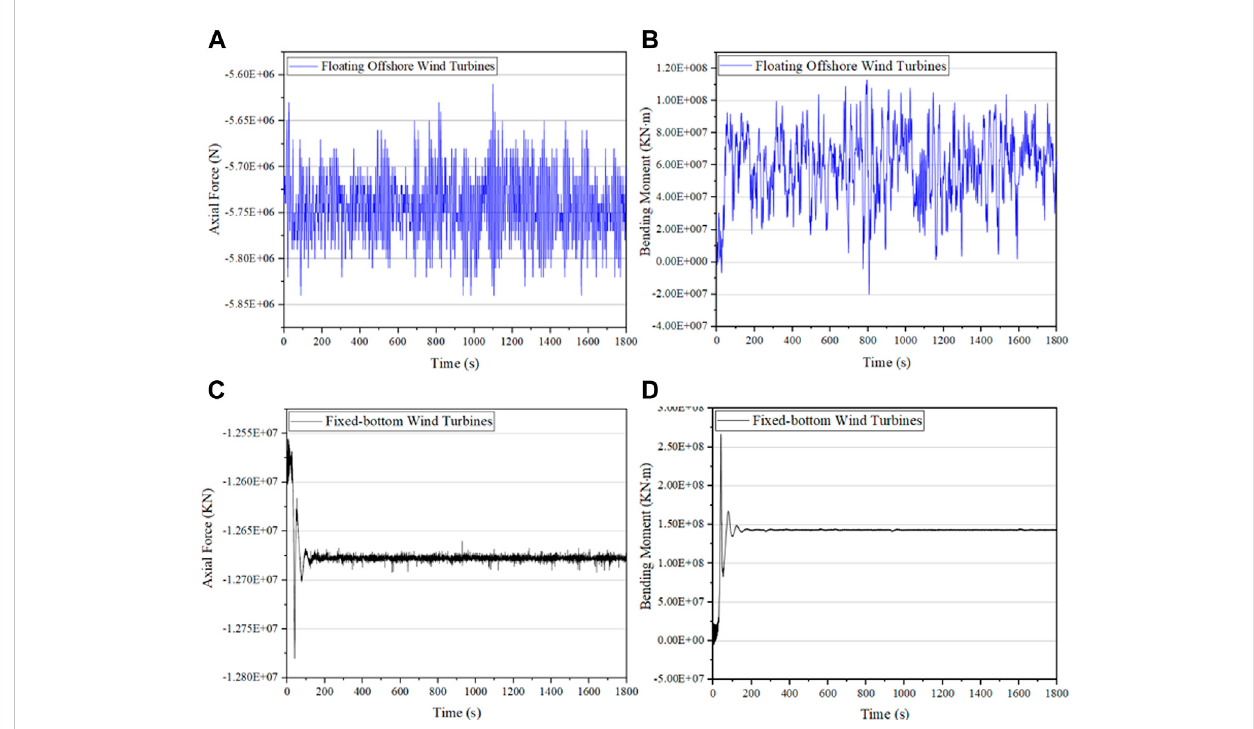
FIGURE 3 TimeseriesoftheaxialforceandthebendingmomentincrosssectionsoftheOWTs ’ tower. (A) AxialforceabovetheFOWTs ’ boltedconnection. (B) Bending moment above the FOWTs ’ bolted connection. (C) Axial force above the FBWTs ’ bolted connection. (D) Bending moment above the FBWTs ’ bolted connection.